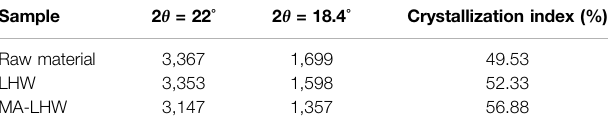
TABLE 2 | Effect of different methods on relative crystallinity of Moso bamboo.